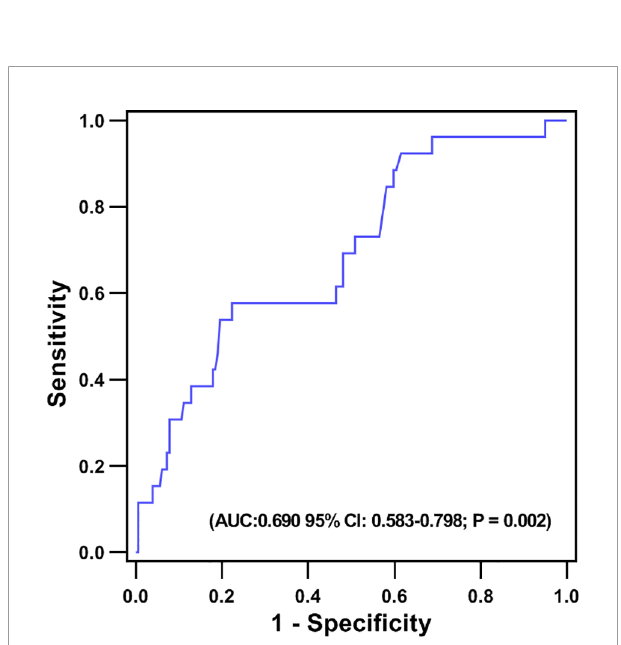
FIGURE 4 | Receiver operating characteristic (ROC) curve of the ability of fT3 to predict MACE in MINOCA patients.